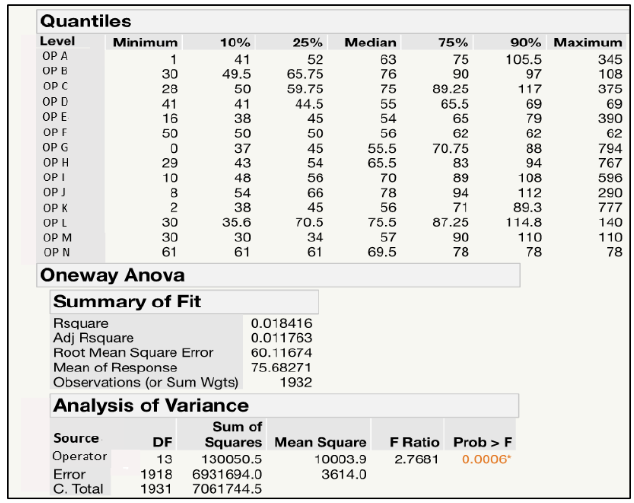
Figure 7. ANOVA: Molten-metal-making times versus 14 furnace operators. * indicates that the